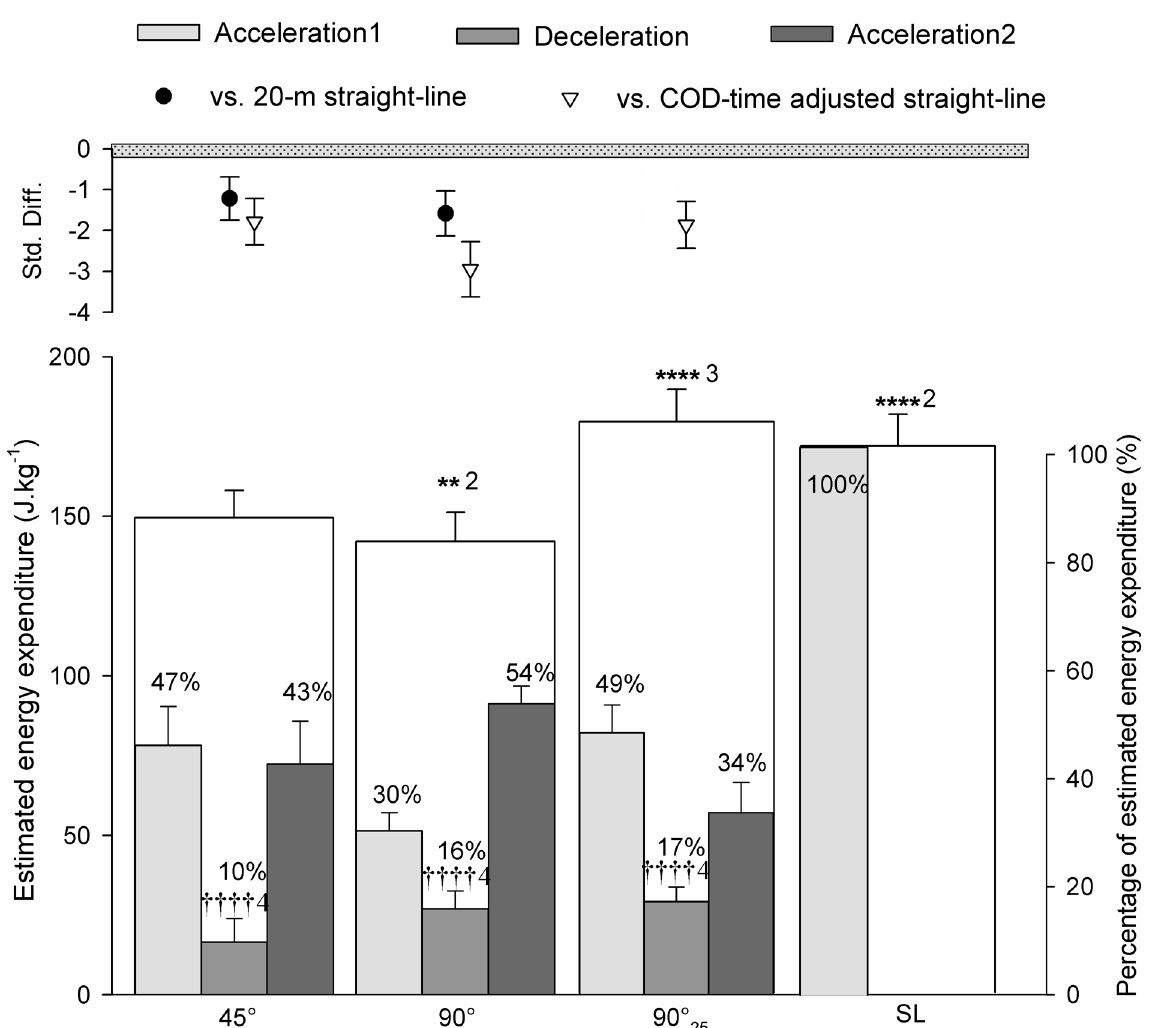
Fig 2. Estimated energy expenditure of sprints with (45° or 90°) or without (i.e., straight-line, SL) one change of direction (COD). 90° 25 : 25-m sprint with one 90°-COD. The upper panel represents the standardized difference (Std Diff) between COD- and SL sprints. Since 90° 25 vs. 20-m SL sprints could not be properly compared (i.e., differences in both running time and distance), their standardized difference (black circle) was not provided. The number of ‘ * ’ and ‘†’ refers to possible, likely, very likely and almost certain between-sprints differences versus the 45°-COD sprint trial, and within-sprint differences vs. the acceleration phases, respectively. The associated number refers to the magnitude of the difference, with 1 standing for small, 2 for moderate, 3 for large and 4 for very large